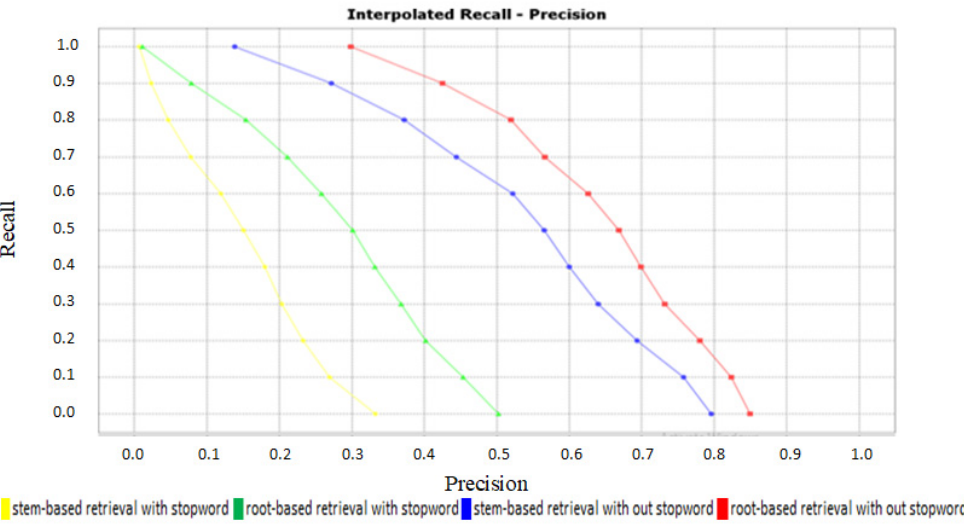
Figure 2. Retrieval effectiveness with and without stopwords.